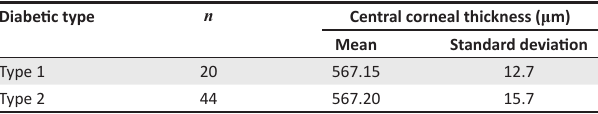
TABLE 2: Mean Central corneal thickness of Type 1 and Type 2 diabetic patients.